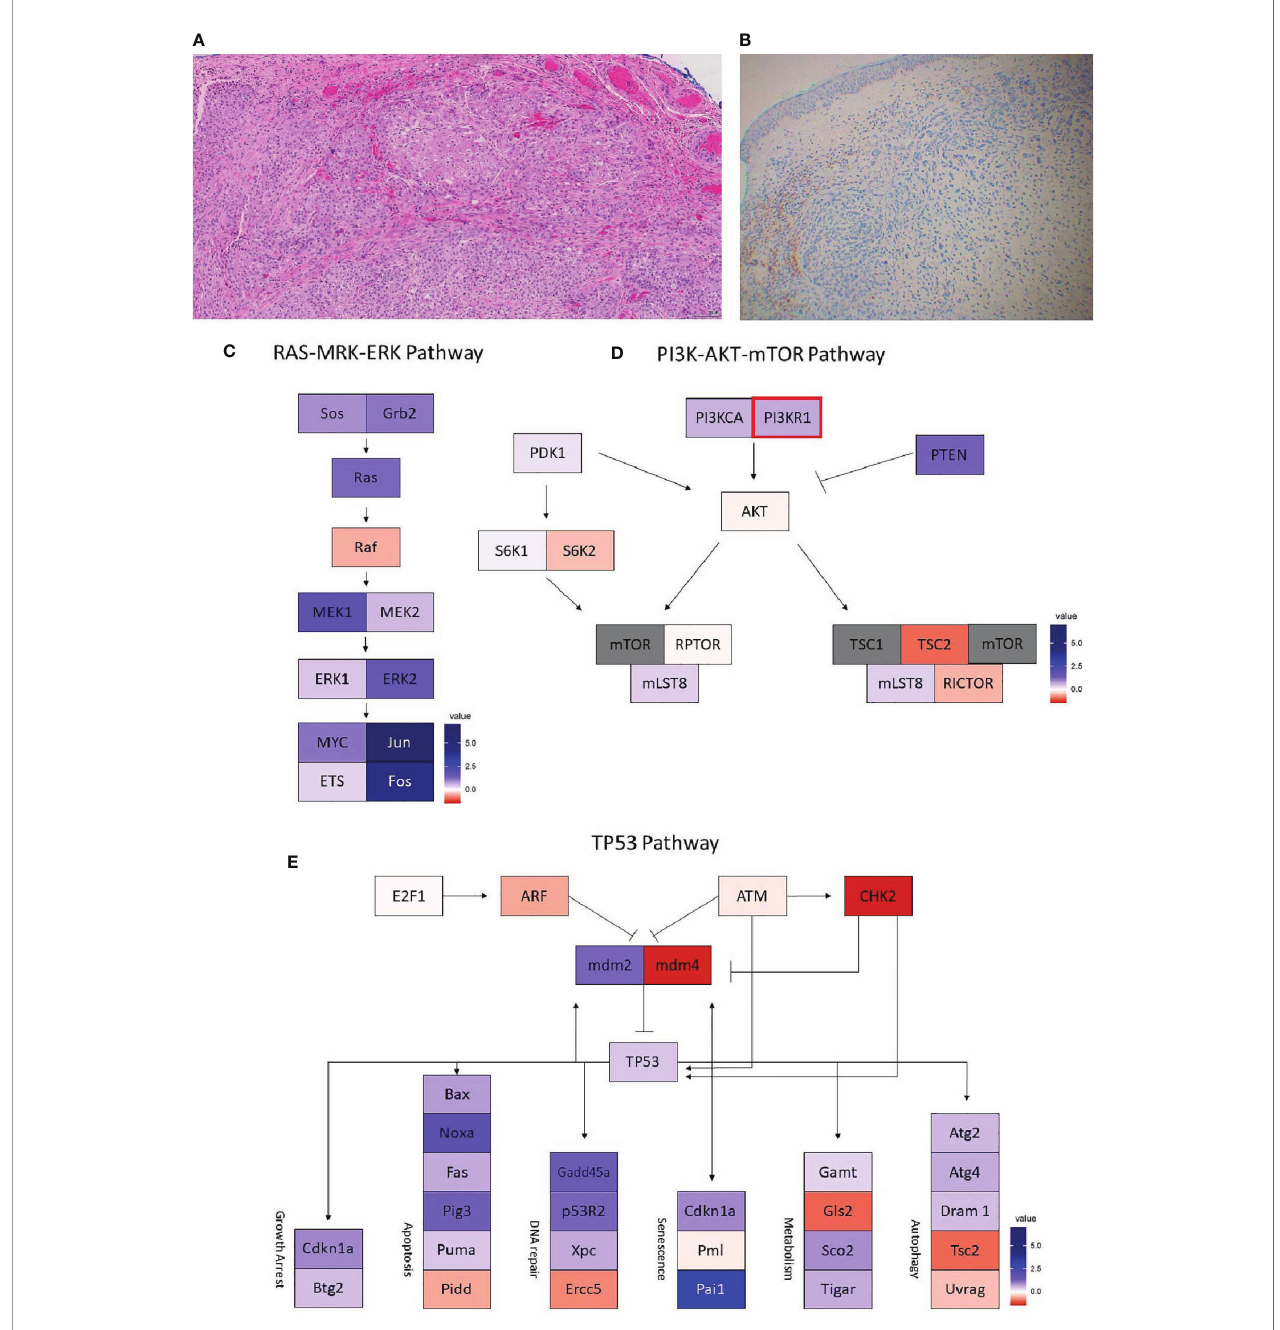
FIGURE 4 | Case 4 (A) H&E image, showing metaplastic squamous carcinoma (B) PD-L1 by the Ventana PD-L1 SP263 assay. Images (C – E) show RNA expression heatmaps with modi fi ed z-scores of expression vs. non-metaplastic TNBC cases in pathways of interest for metaplastic breast cancer (C) RAS-MEK- ERK, (D) PI3K-AKT-mTOR (E) TP53. Genes with DNA mutations are outlined in